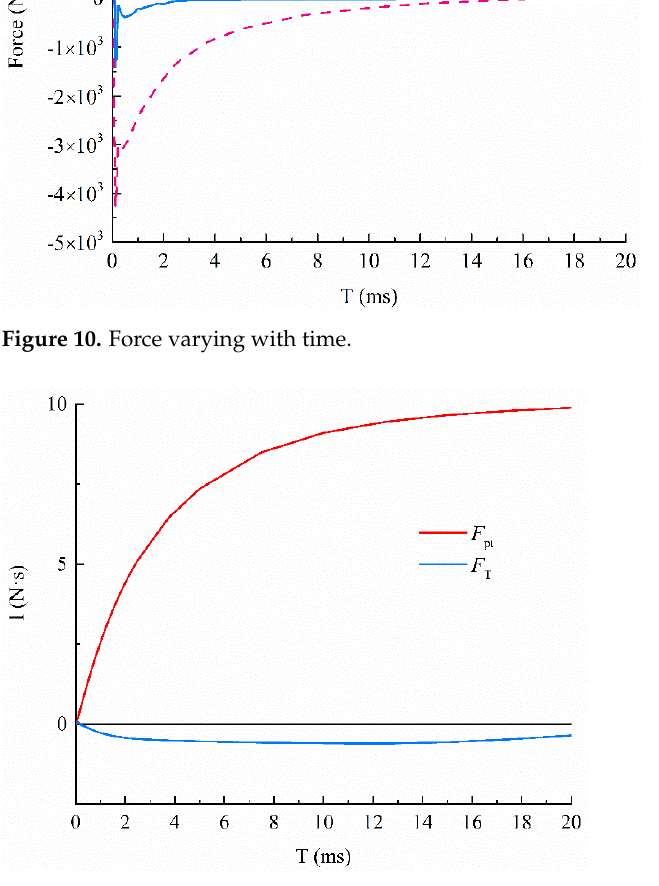
Figure 11. Impulse varying with time.